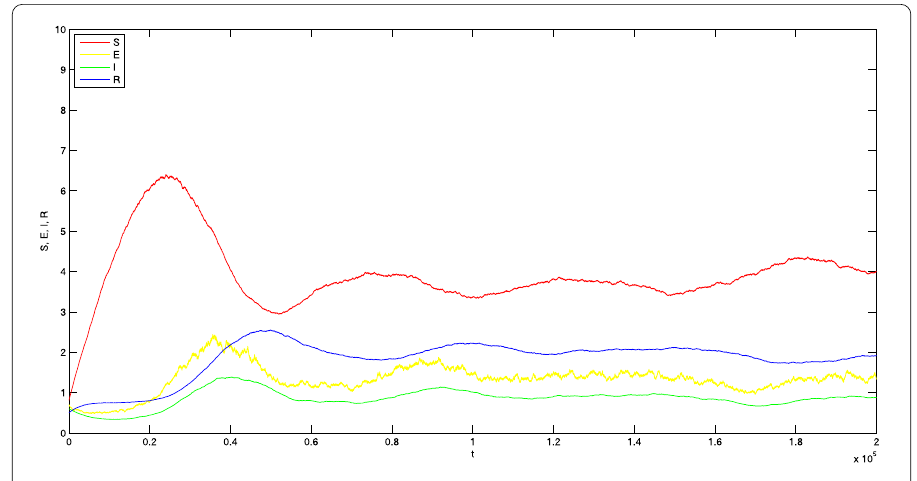
Figure 4 A realization of persistence in the mean for the susceptible, the exposed, the infected, and the recovered to model (2)